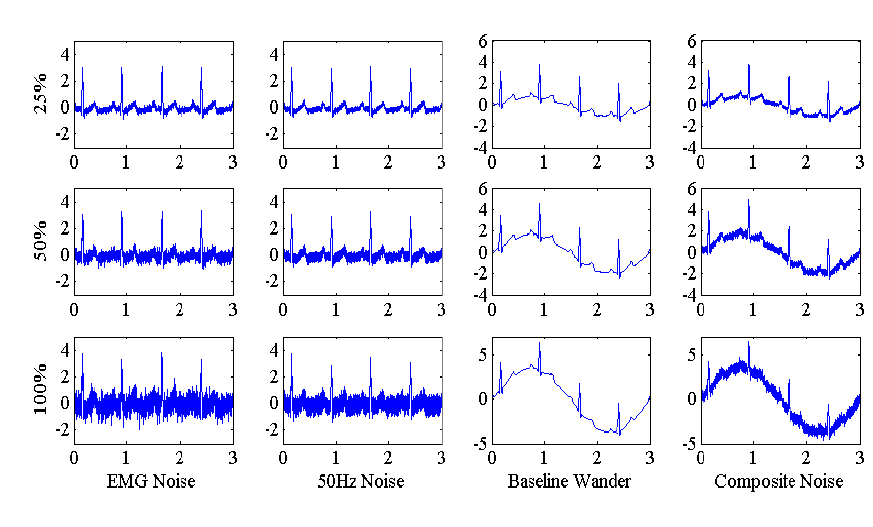
Figure 3. Illustration of EMG noise, 50 Hz noise, baseline wander and composite of three noises on normal ECG. Noise levels of 25%, 50% and 100% are added, respectively. Signal durations are 3